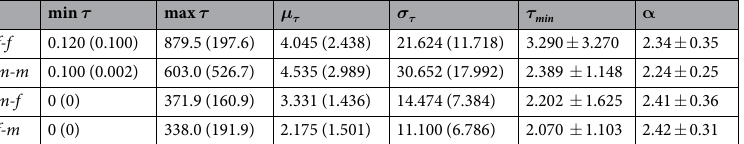
Table 1. Measured values and estimated parameters of the calling behavior. Abbreviations: f-f : female self- contained callings; m-m : male self-contained callings; m-f : female reactive callings; f-m : male reactive callings; min τ : minimum inter-event interval (in seconds); max τ : maximum inter-event interval (in seconds); μ τ : mean inter-event interval (in seconds); σ τ : standard deviation of inter-event interval (in seconds); τ min : lower bound for fitting algorithms (in seconds); α : exponent of power-law distribution. (measured value: median (25% quantile); estimated parameter: mean ± SD, n =